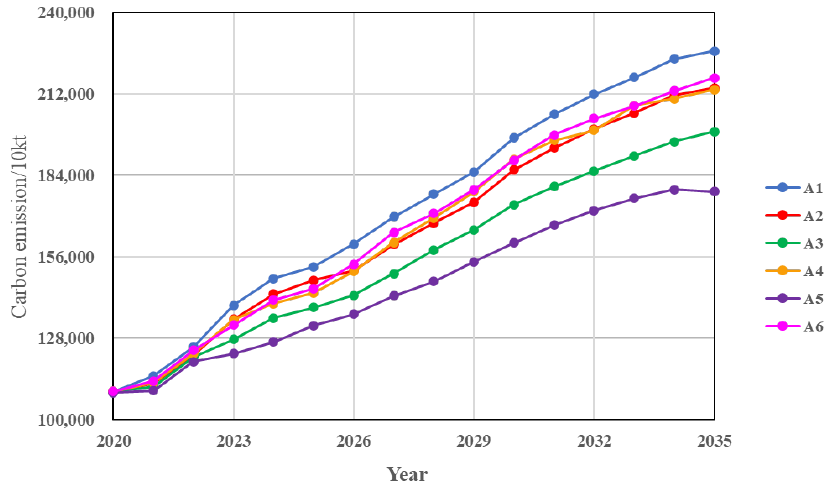
Figure 6. Carbon emission predications for urban agglomeration under different single regulation scenarios. Table 8. Reduction rate of average cumulative carbon emissions over the projection period compared to the baseline scenario under different single scenarios.